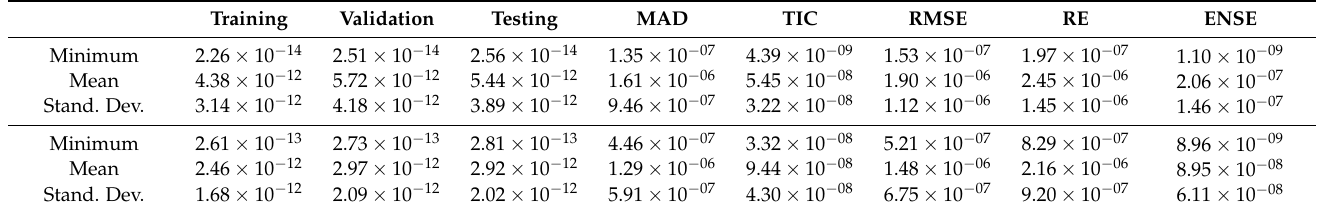
Table 7. Statistical analysis of the values of the validation, testing, and training data along with performance measures computed for the error in the solutions of velocity and acceleration for the micropolar fluid flow with isoflux boundary